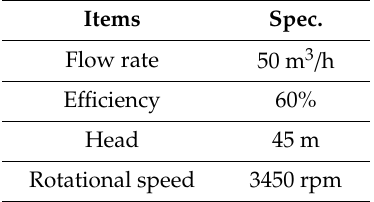
Table 1. Operational specifications at the design points of the pump with balancing holes.